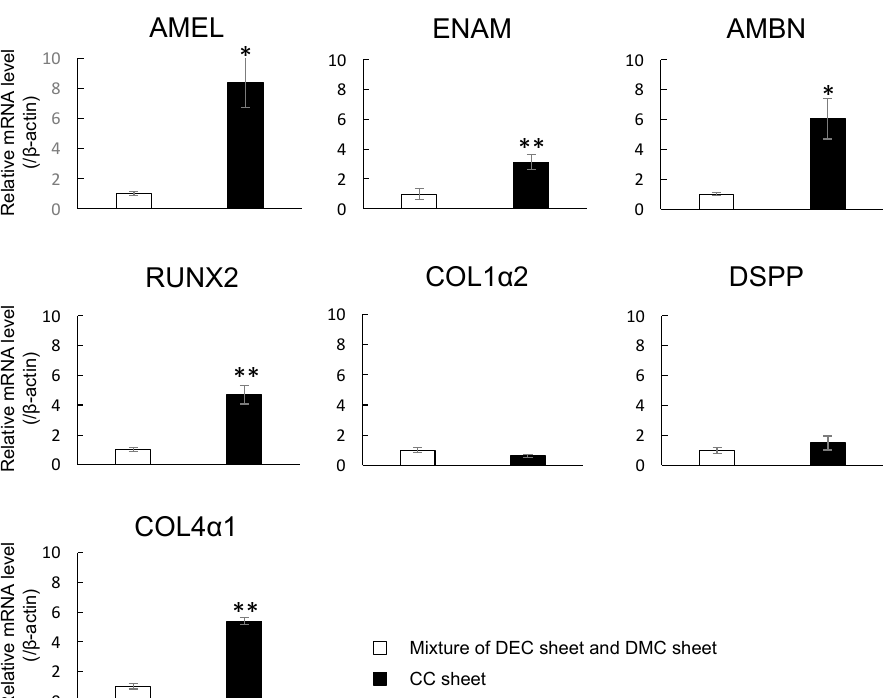
Figure 7. mRNA expression levels of AMEL , ENAM , AMBN , RUNX2 , COL1 α 2 , DSPP , and COL4 α 1 in CC sheet examined by real-time RT-PCR. A mixture of DEC and DMC sheets prepared separately were used as a control. Real-time RT-PCR data were normalized to the expression levels of β -actin mRNA. Independent experiments were repeated twice. Data represent the mean ± SD of triplicate samples. * p < 0.05. ** p < 0.01.